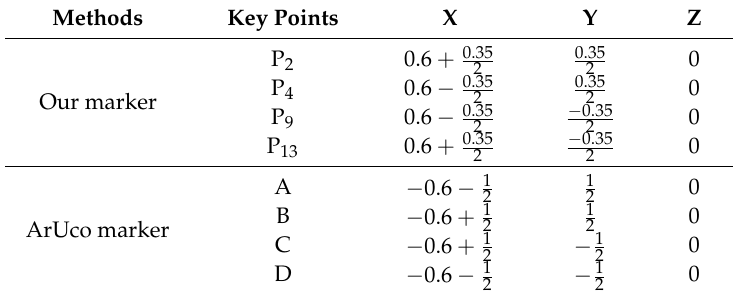
Figure 17. Experimental setup of our marker and ArUco marker for estimating full pose. Table 6. 3D coordinates of all detect key points of ArUco marker and our proposed marker.